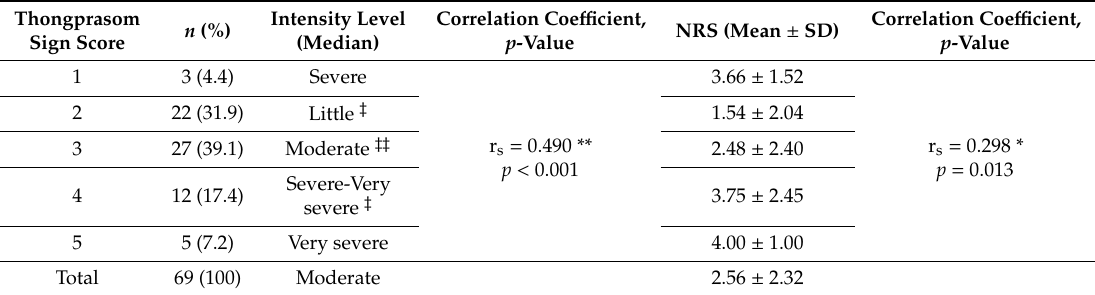
Table 2. Association and distribution of the intensity of oral impacts and NRS by the OLP clinical severity according to the Thongprasom sign